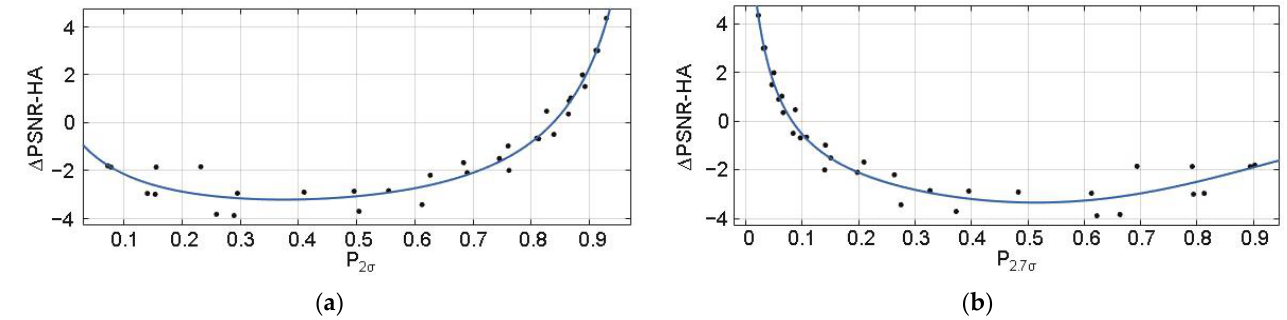
Figure 5. The scatter-plots ∆𝑃𝑆𝑁𝑅 − 𝐻𝐴 vs. 𝑃 2𝜎 ( a ) and vs. 𝑃 2.7𝜎 ( b ) and the fitted curves (format